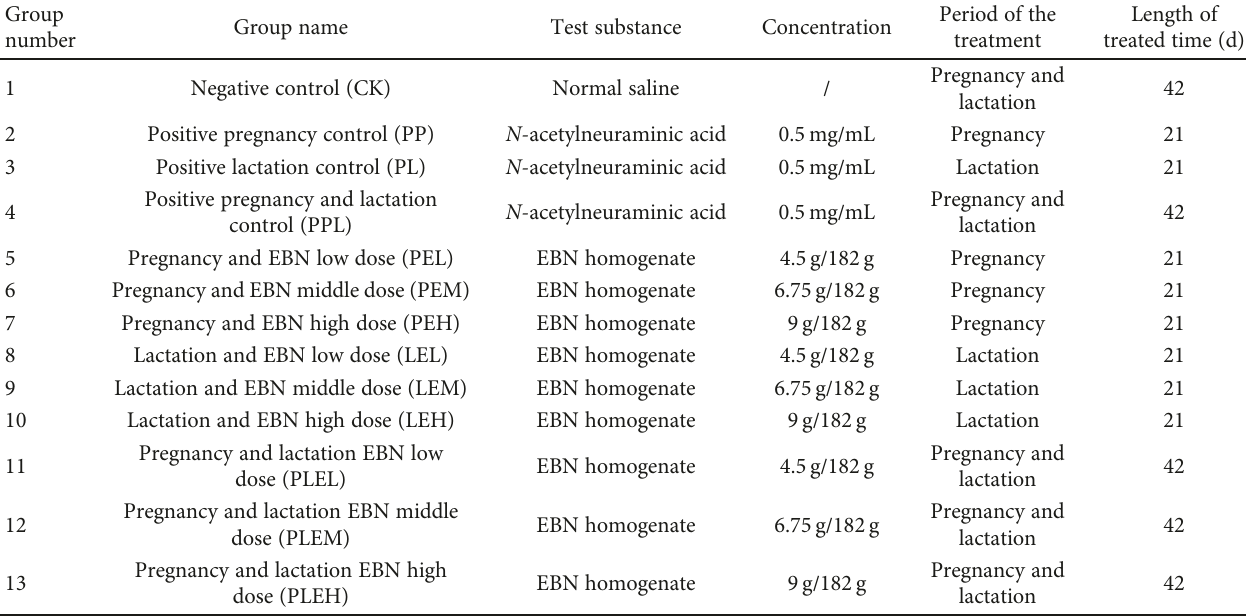
Table 1: Details of grouping and oral administration of the test